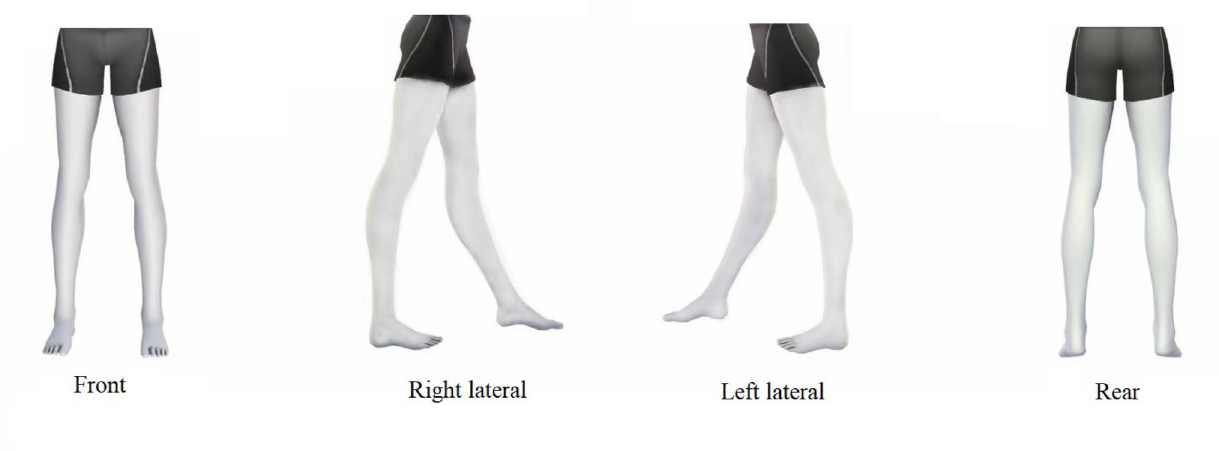
Fig 2. Standing posture of